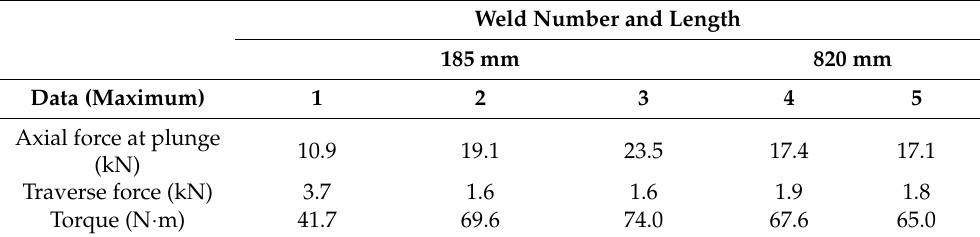
Table 1. Forces obtained in welds using 600 mm/min and 600 RPM.